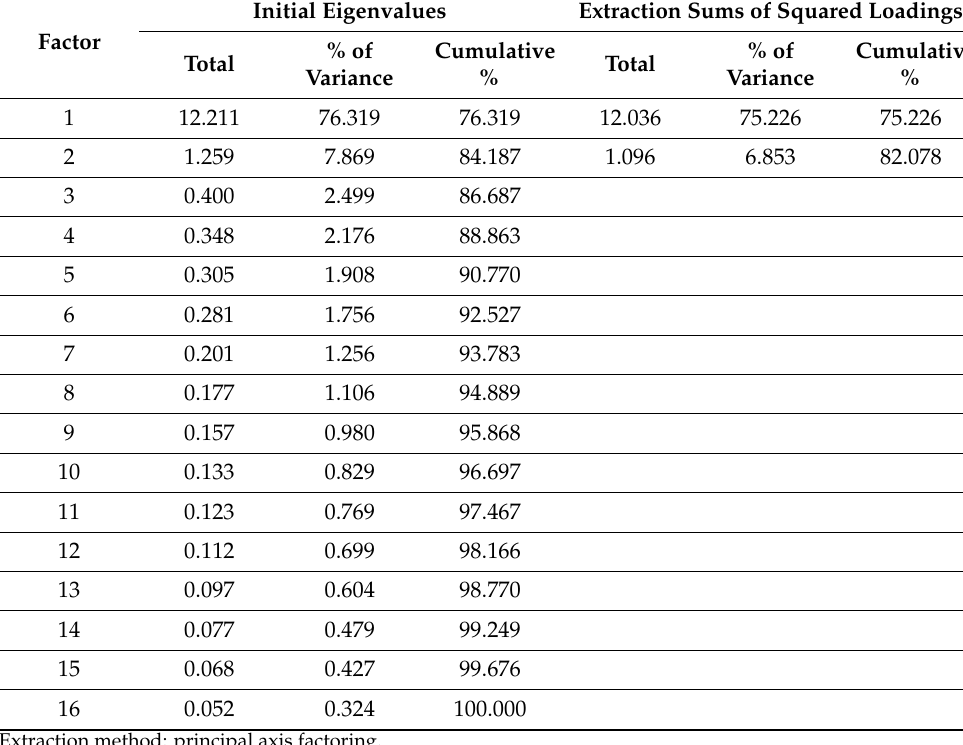
Table 9. Total variance explained for factors.